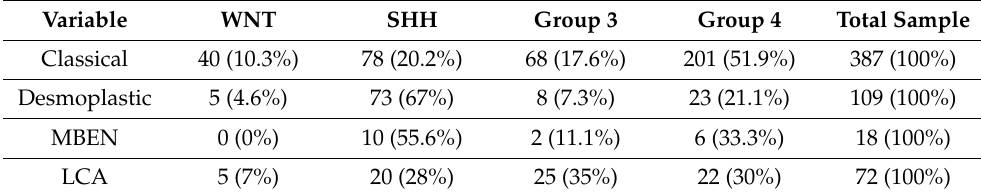
Table 2. Histological X molecular diagnosis of medulloblastomas.